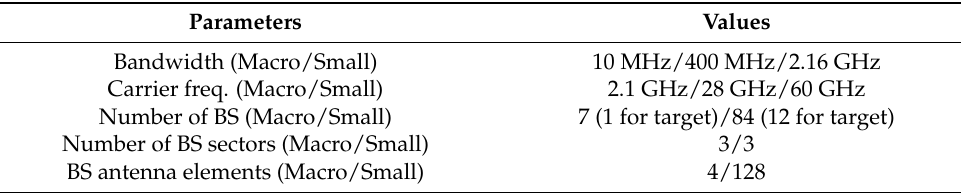
Table 4. The simulation